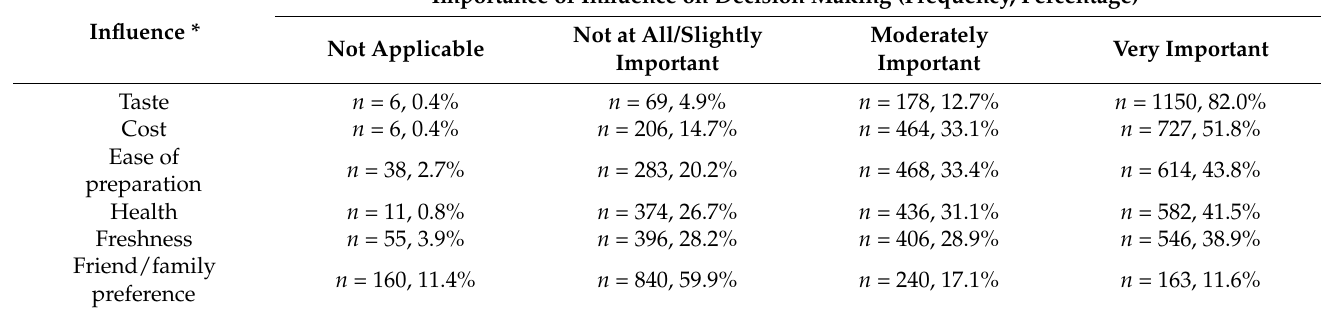
Table 2. Importance of various influences on decision making around the purchase of seaweed ( n = 1403).